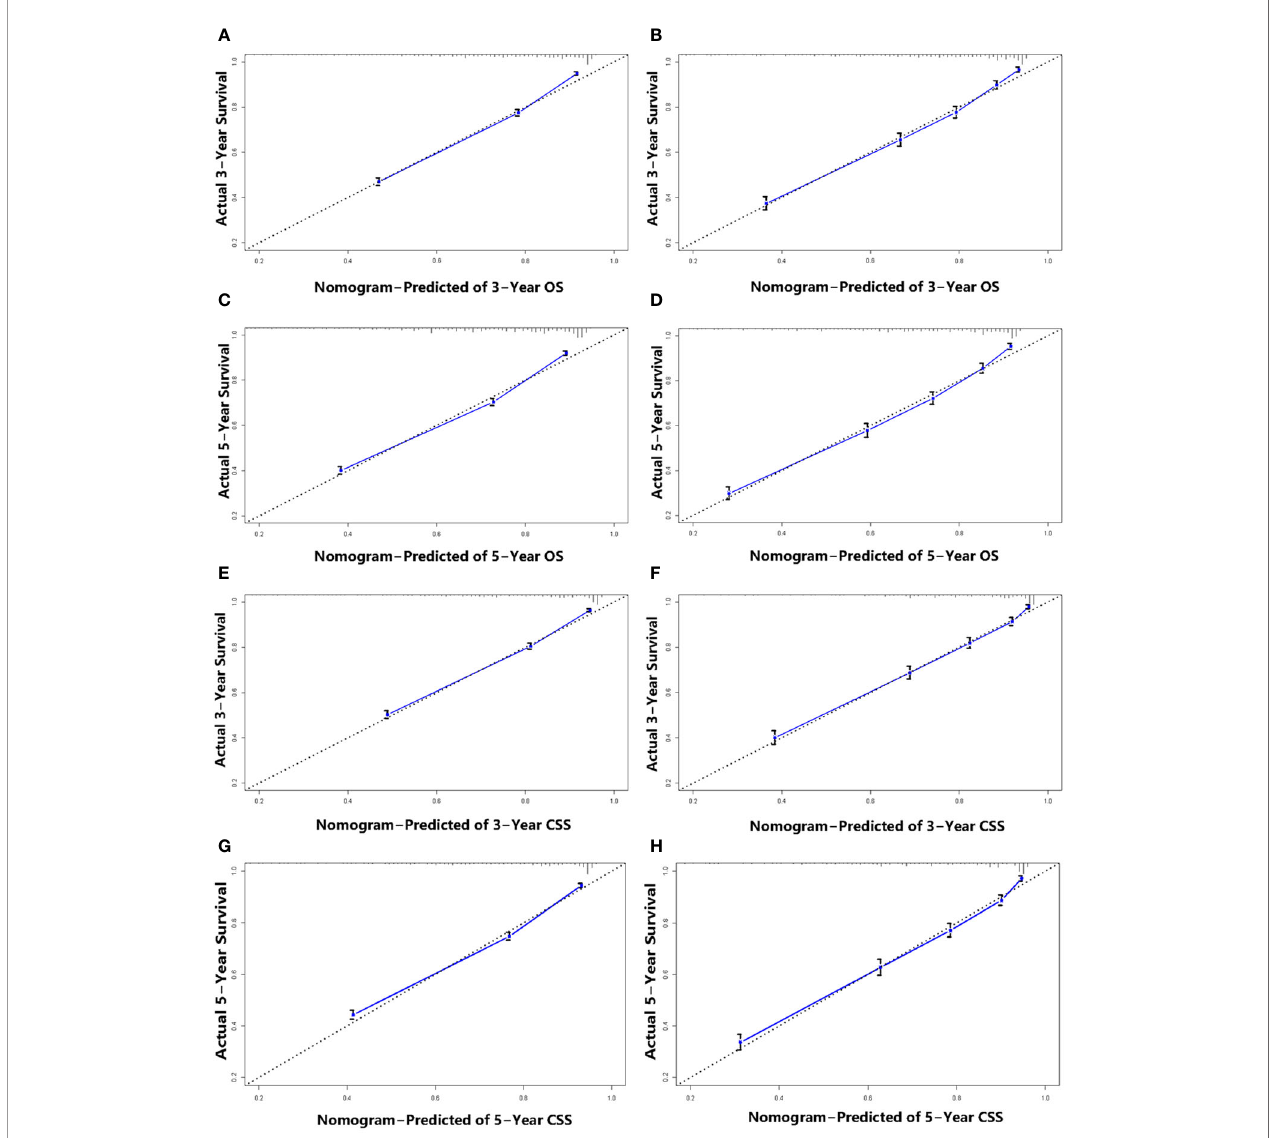
FIGURE 4 | Calibration plots for 3-, and 5-year OS prediction for the training cohort (A, C) and validation cohort (B, D) . Calibration plots for 3-, and 5-year CSS prediction for the training cohort (E, G) and validation cohort (F, H)